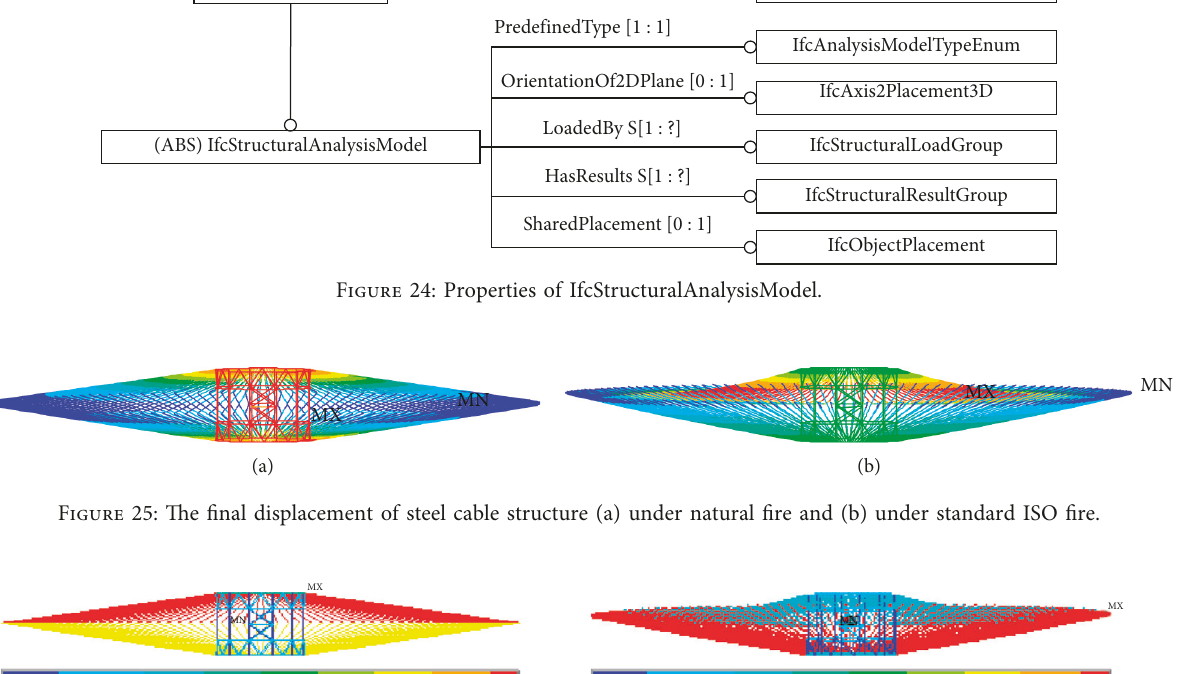
−0.111 E + 09 −0.410 E + 08 Figure 26: The stress of a steel cable structure (a) under natural fire and (b) under standard ISO